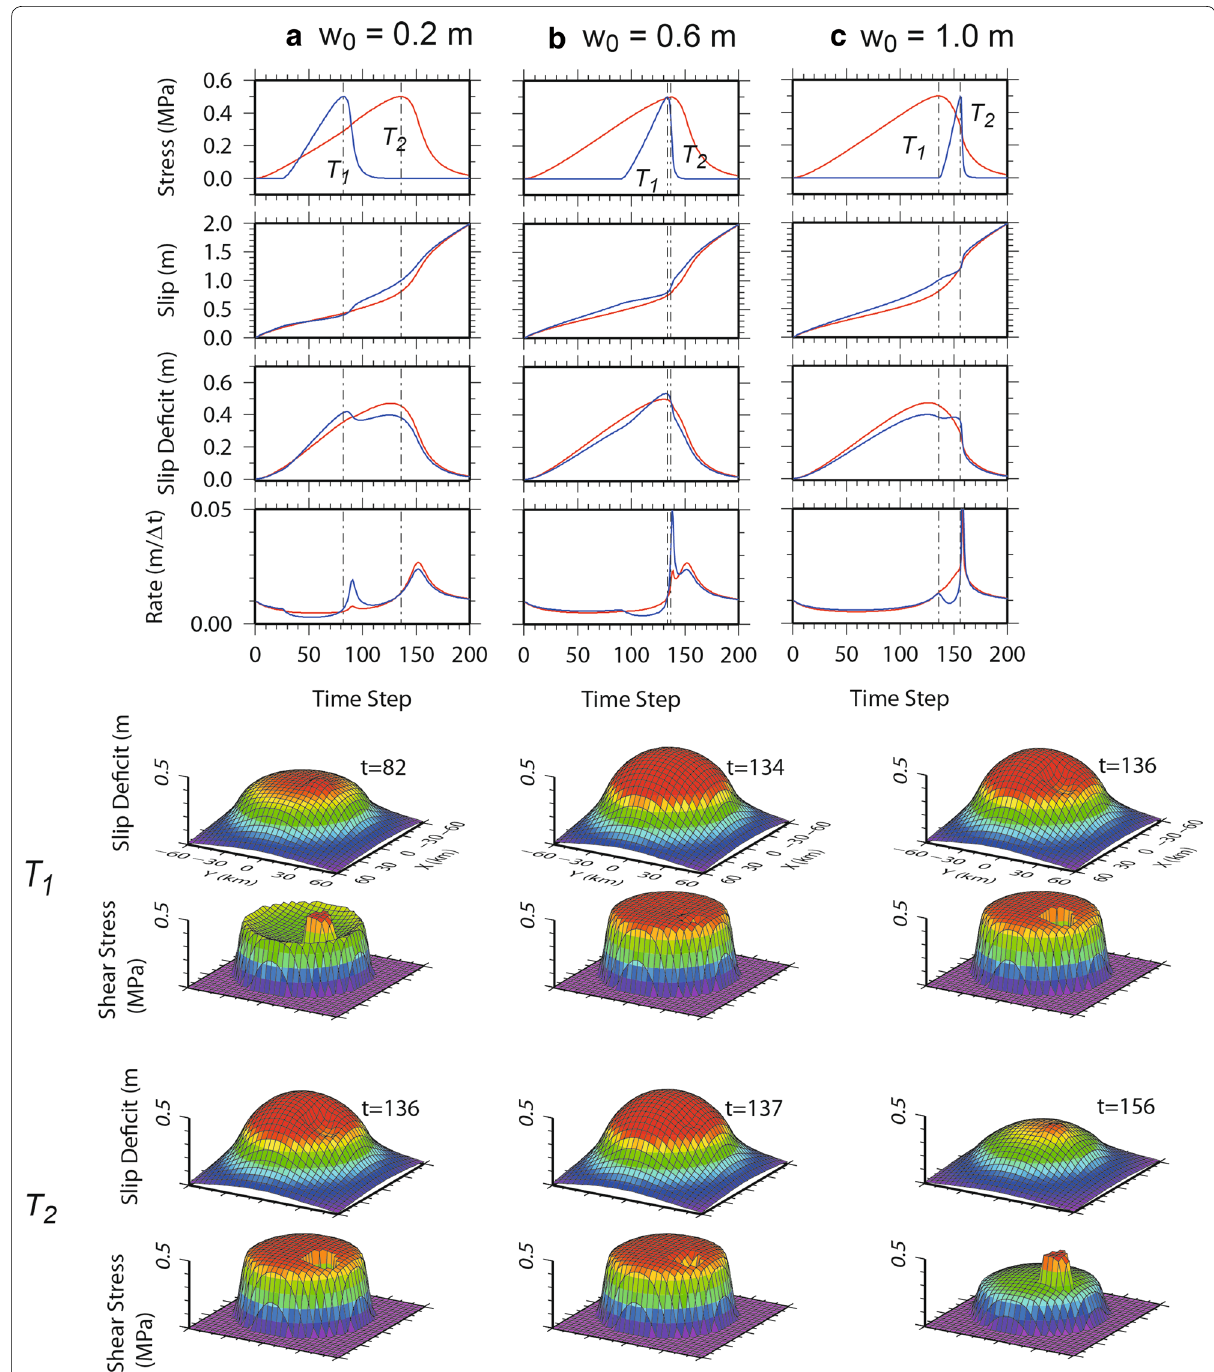
Fig. 5 Evolution of shear stress and slip behaviors for L ( red ) and S ( blue ), where a w 0 = 0.2m , b w 0 = 0.6m , and c w 0 = 1.0m . Plots of temporal changes in shear stress, total slip, slip deficit, and slip rate are shown for each case. Stress values are extracted from the center of each patch, while the slip quantities are averaged across each patch. The times T 1 and T 2 are indicated by broken lines when the shear stress has a peak at either of two patches (L or S) just before the weakening process, and the corresponding spatial distributions of slip deficit and shear stress are illustrated in the following